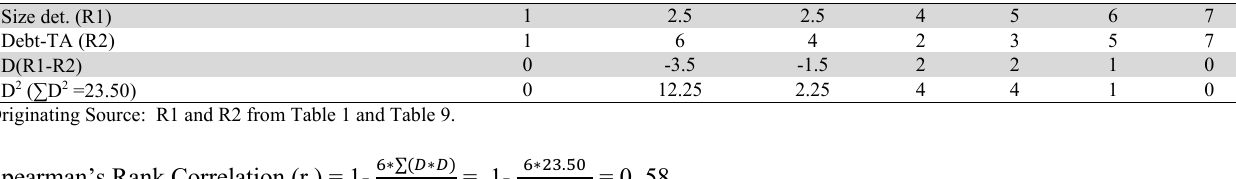
Rank correlation between averages of size determinants ranks and Debt- TA ratio Indian pharmaceutical companies Ranks Su Lu